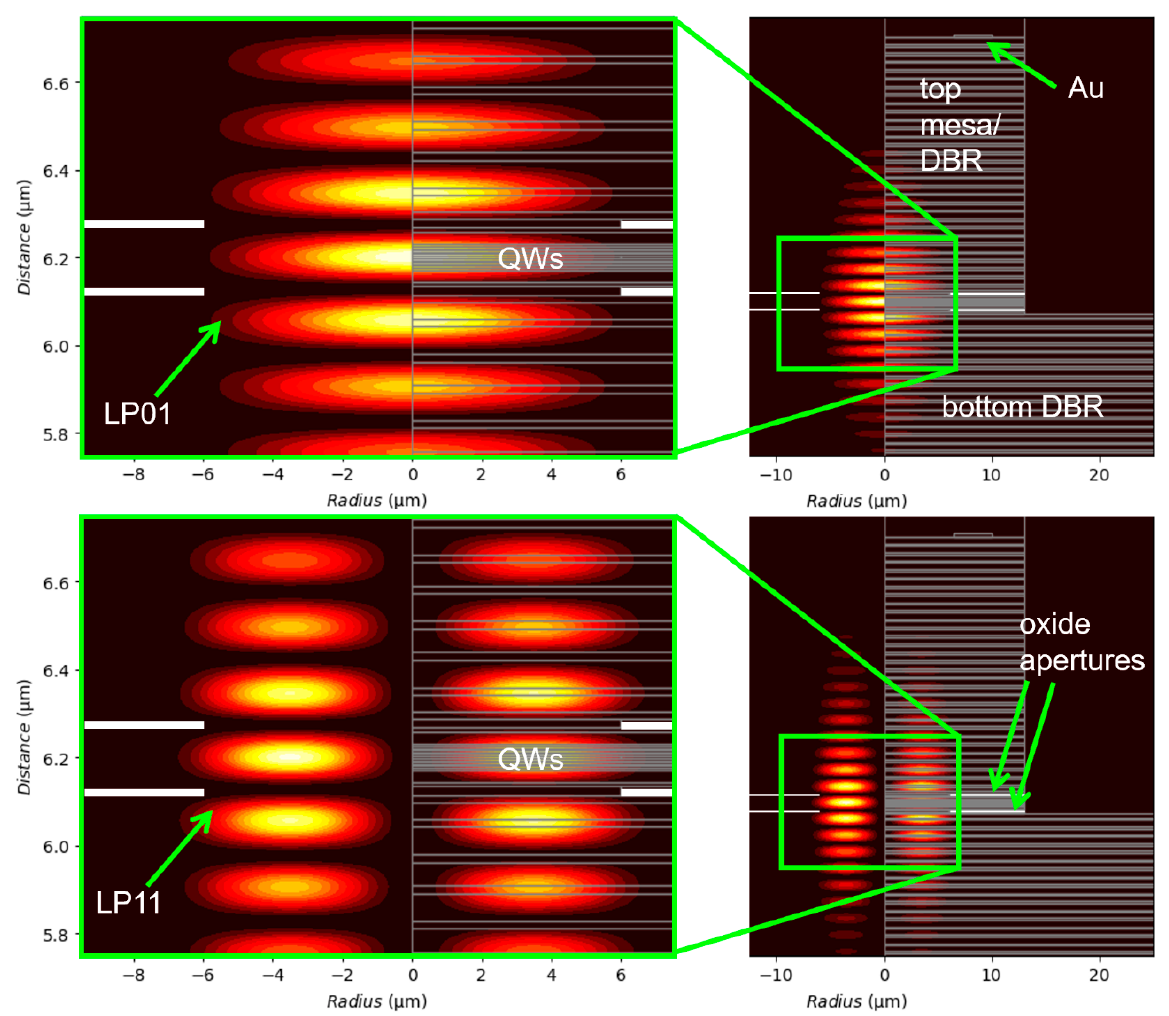
Figure 7. Simulated two-dimensional LP01 and LP11 cold cavity modes (normalized resonant optical field intensities) for a cylindrically symmetric (rotated 2 π about the vertical line at radius = 0) 980 nm VCSEL with φ ~12 µ m (corresponding to any one of the three VCSELs in the triple array in Figure 6).